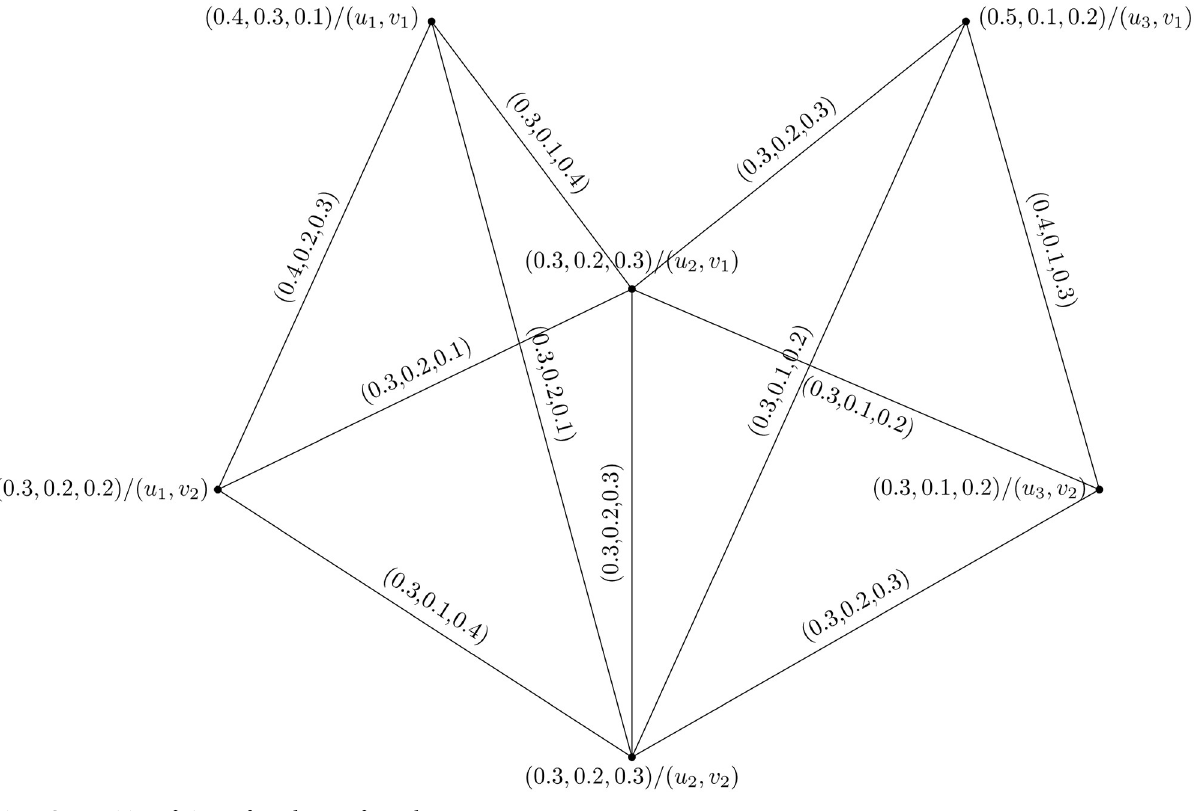
Fig 8. Composition of picture fuzzy hypersoft